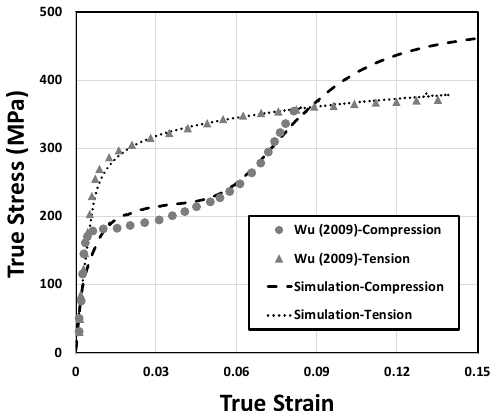
Figure 13. The comparison of the simulated stress-strain response responses of ZK60A Mg alloy subjected to the uniaxial loading along the extrusion direction versus the experimental data of Wu [107] (Yaghoobi et al. [9]).